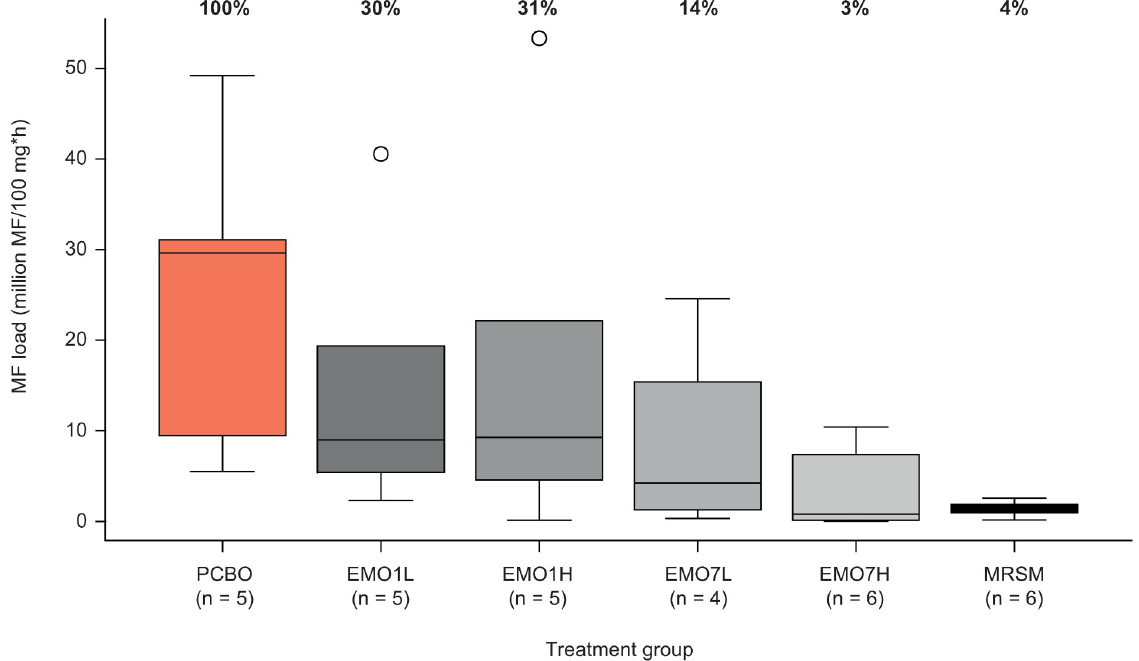
Fig 6. Dermal microfilarial load distribution (area under the curve [load � time]) by treatment group in zebu (Ngaounde´re´ Gudali) cattle ( B . t . indicus ). Dermal microfilarial density was determined at each timepoint by incubation of skin biopsies (in triplicate per animal at each timepoint), normalized to 100 mg skin [59], then used to estimate total area under the load � time curve. The boxplot is ordered by dose steps of emodepside (grey shading). The thick bar is the median, the limits of each box are the interquartile range, the whiskers are the smallest/largest value within 1.5 × the interquartile range, and the open circles are outliers. The placebo control and melarsomine (positive control) are shown in orange and black, respectively. Median microfilaria load per treatment group as a proportion of placebo (normalized to 100%) is shown above the plot. No between-group statistical comparisons were made. EMO1H, emodepside, 0.75 mg/kg, single dose; EMO7H, emodepside, 0.75 mg/kg, daily for seven days; EMO1L, emodepside, 0.15 mg/kg, single dose; EMO7L, emodepside, 0.15 mg/kg, daily for seven days; MF, microfilariae; MRSM, melarsomine, 4 mg/kg, every other day for three days; PCBO, placebo.